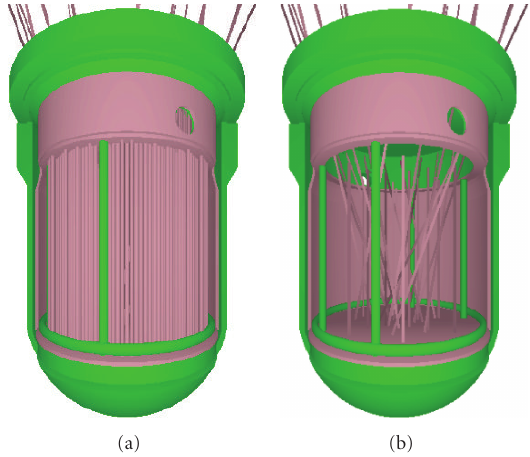
Figure 3: Total neutron flux on the inner surface of RPV